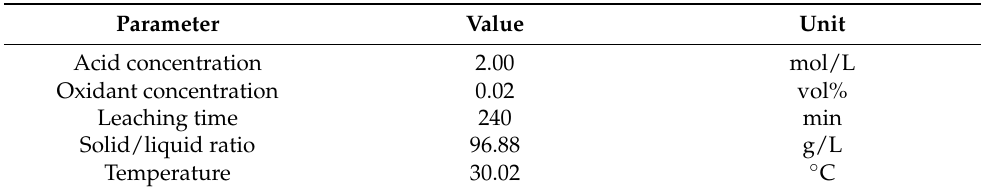
Table 5. Parameter of the optimization calculation of the leaching step. Parameter Value Unit Acid concentration 2.00 mol/L Oxidant concentration 0.02 vol% Leaching time 240 min Solid/liquid ratio 96.88 g/L Temperature 30.02 ◦